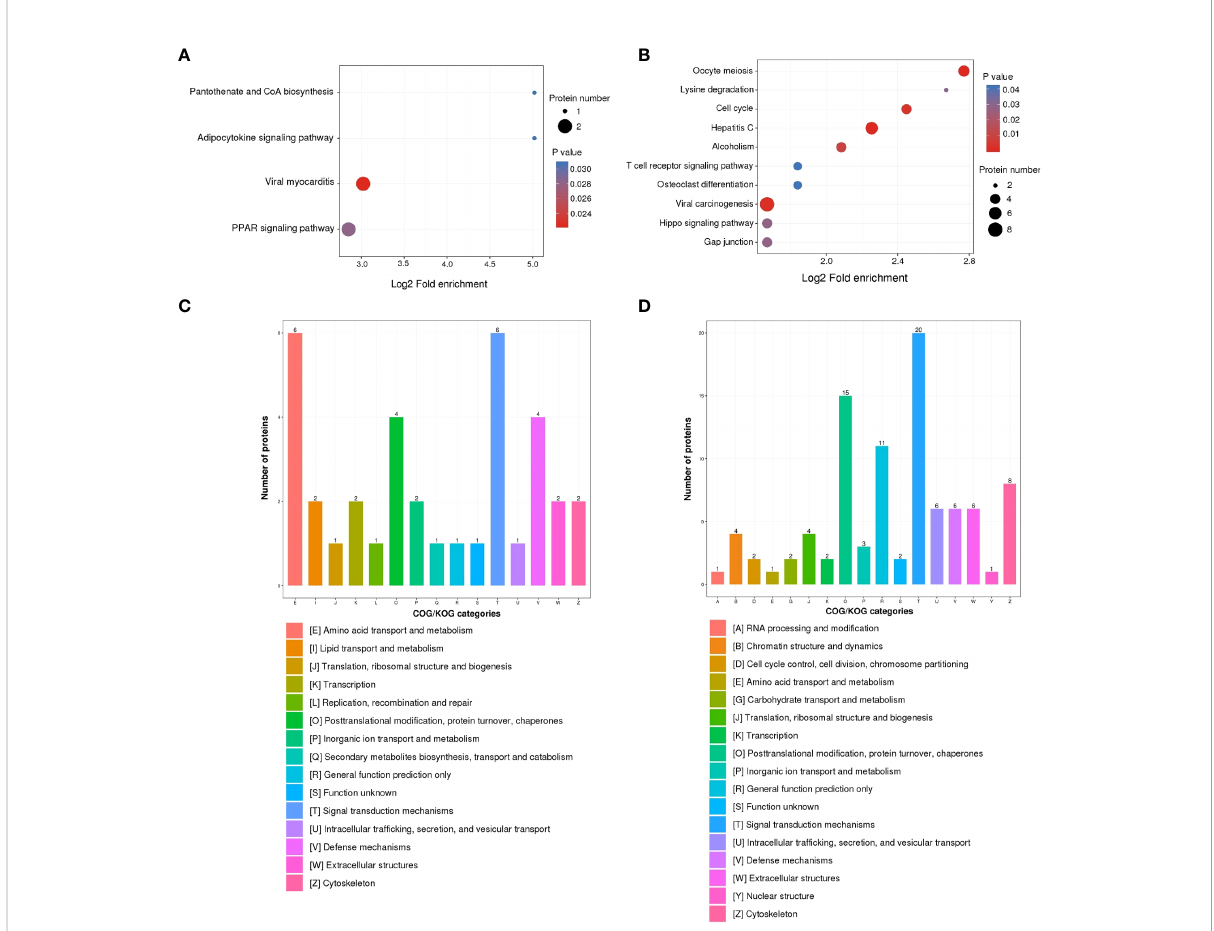
FIGURE 3 KEGG pathway and COG/KOG functional classi fi cation analysis of DEPs in ASFV-infected versus uninfected samples using quantitative proteomics. KEGG pathway analysis of (A) upregulated DEPs and (B) downregulated DEPs. COG/KOG functional classi fi cation analysis of (C) upregulated DEPs and (D) downregulated